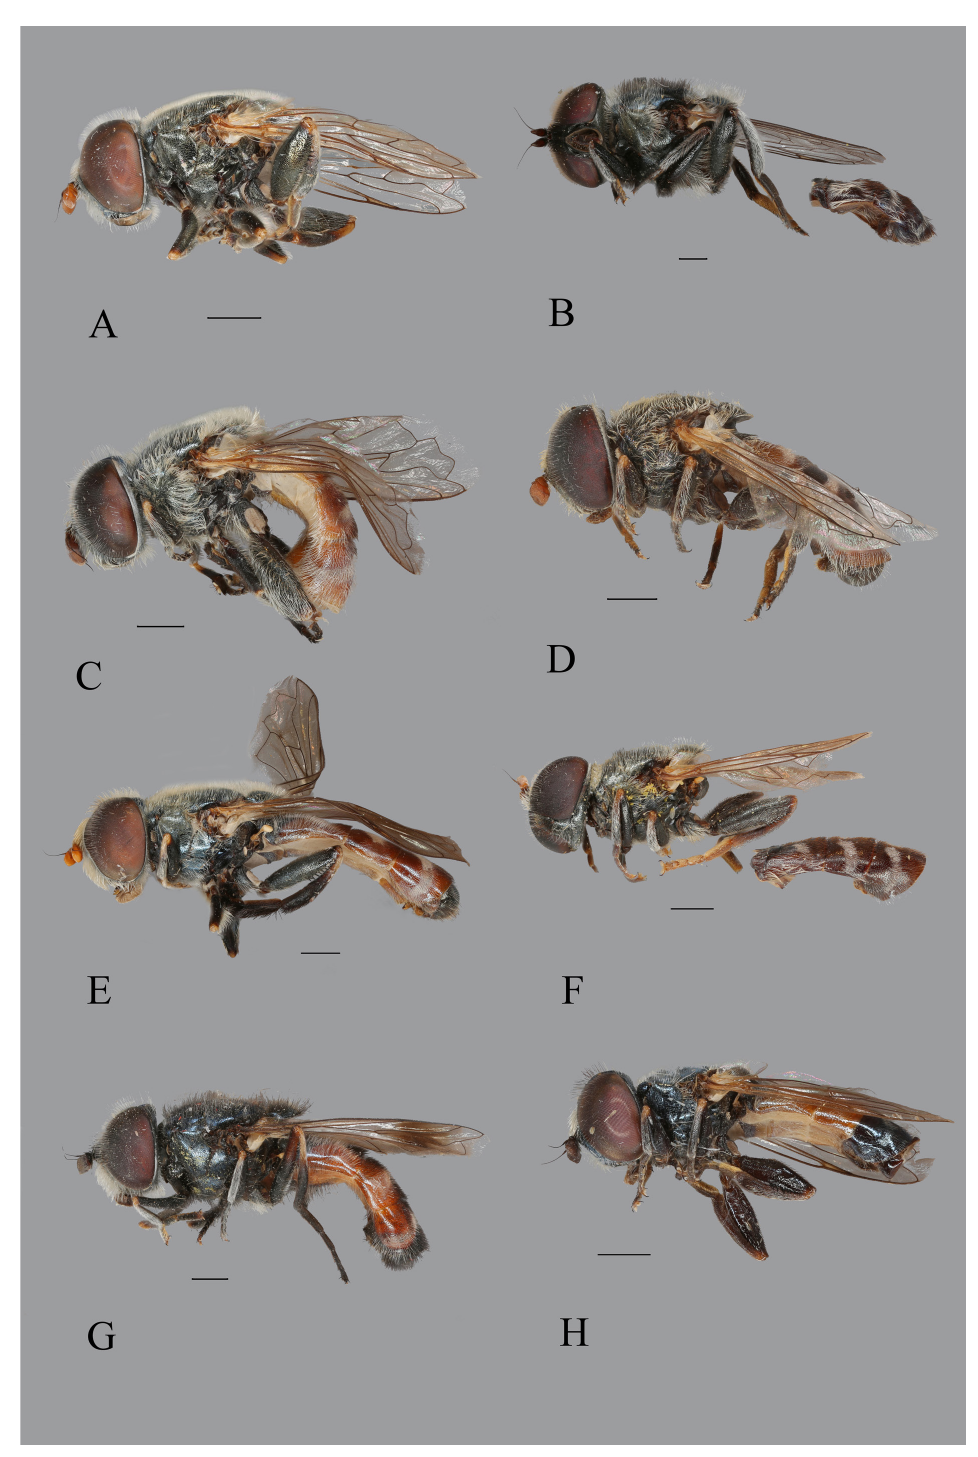
Fig. 7. Adult habitus, ♂, lateral view. A . Eumerus sp., Khash, Iran (HMIM). B . E. hissaricus Stackelberg, 1949, Ghoochan, Iran (HMIM). C . E. ovoformus Gilasian & van Steenis sp. nov., holotype (HMIM). D . E. persarum Stackelberg, 1961, Yazd, Iran (JSA). E . E. pilosipedes Gilasian & van Steenis sp. nov., holotype (HMIM). F . E. richteri Stackelberg, 1960, Lar, Iran (HMIM). G . E. tadzhikorum Stackelberg, 1949, Chekab Valley, Iran (JSA). H . E. vallicolous Gilasian & van Steenis sp. nov., holotype (HMIM). Scale bars = 1.0